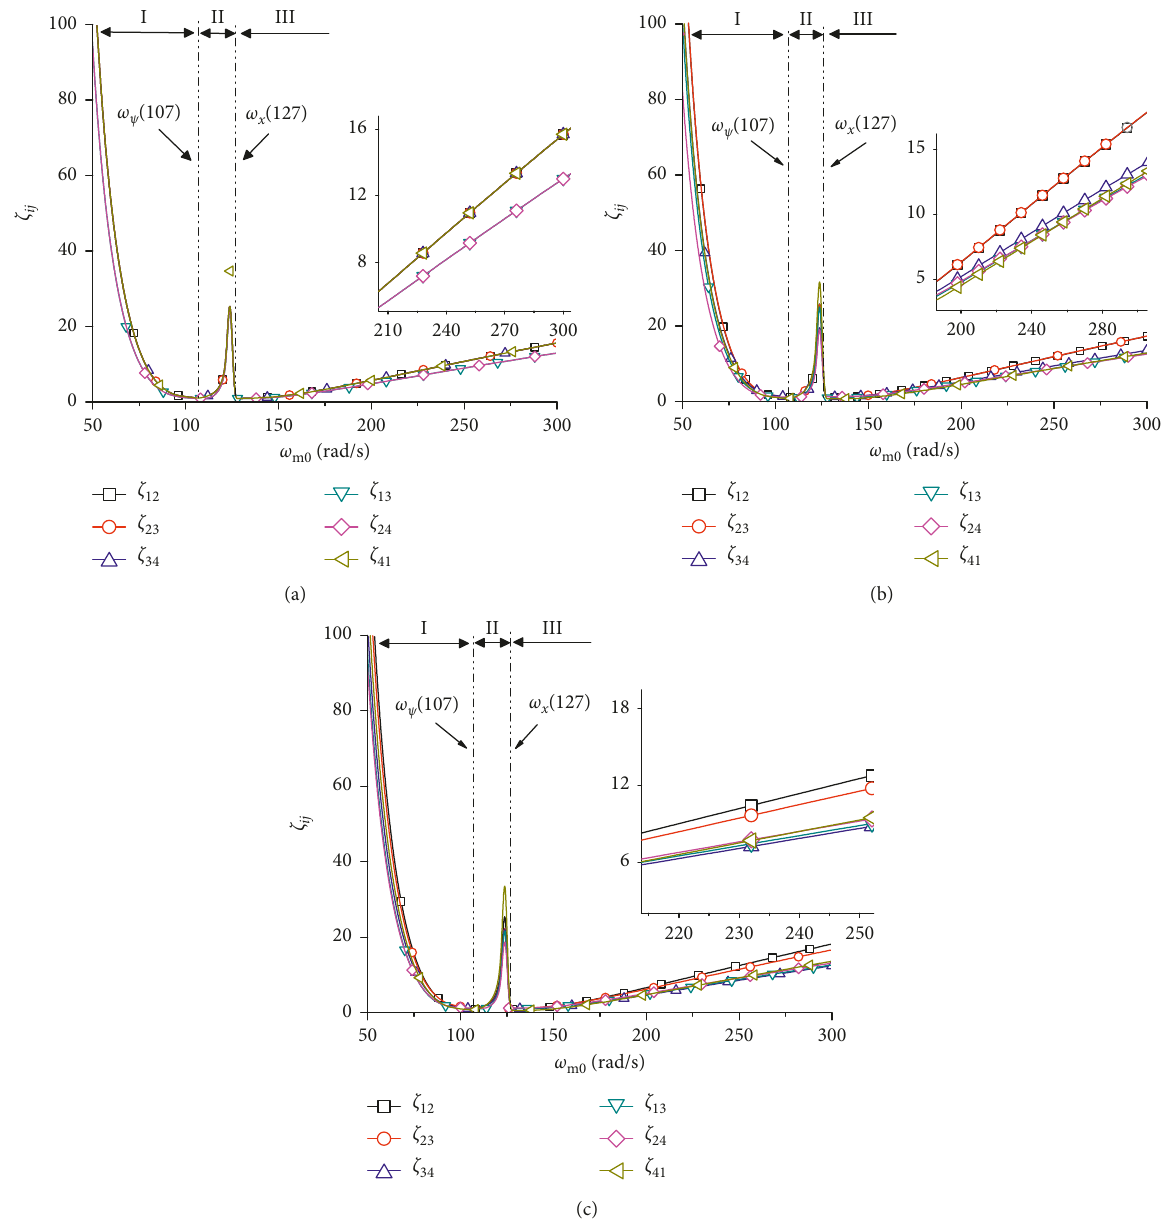
Figure 3: CGDSs among four vibrators in different η (c) η 1